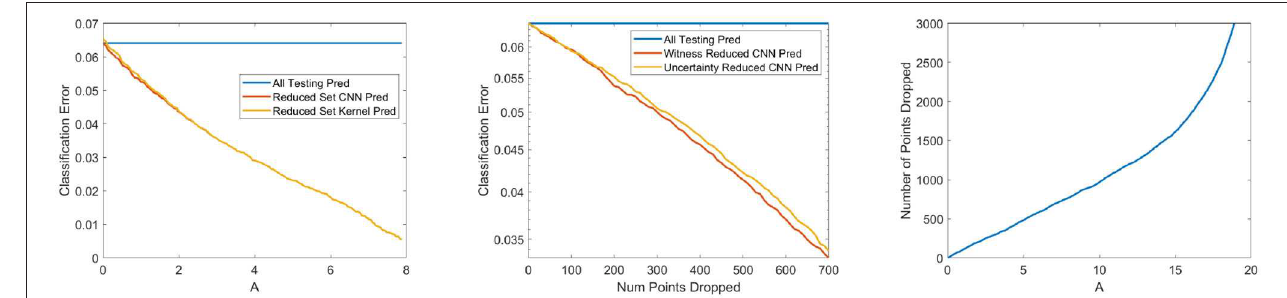
FIGURE 4 | (Left) Classification error on points deemed “significant” as a function of A . (Middle) Classification error as a function of the number of points removed for being “uncertain,” for both the witness function and the size of gap of CNN outputs. These two measures are placed on the same scale by considering the number of points removed. (Right) The relationship between the number of points dropped and parameter A in our